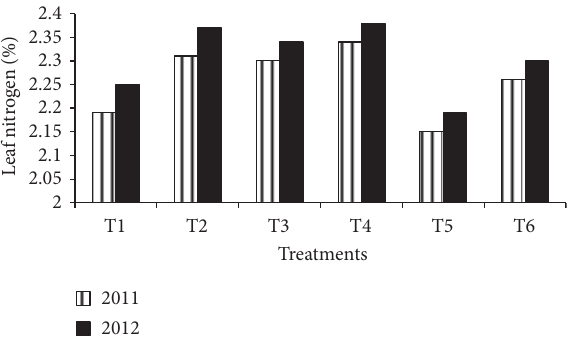
Figure 2: Leaf nitrogen content as influenced by N&K fertigation in